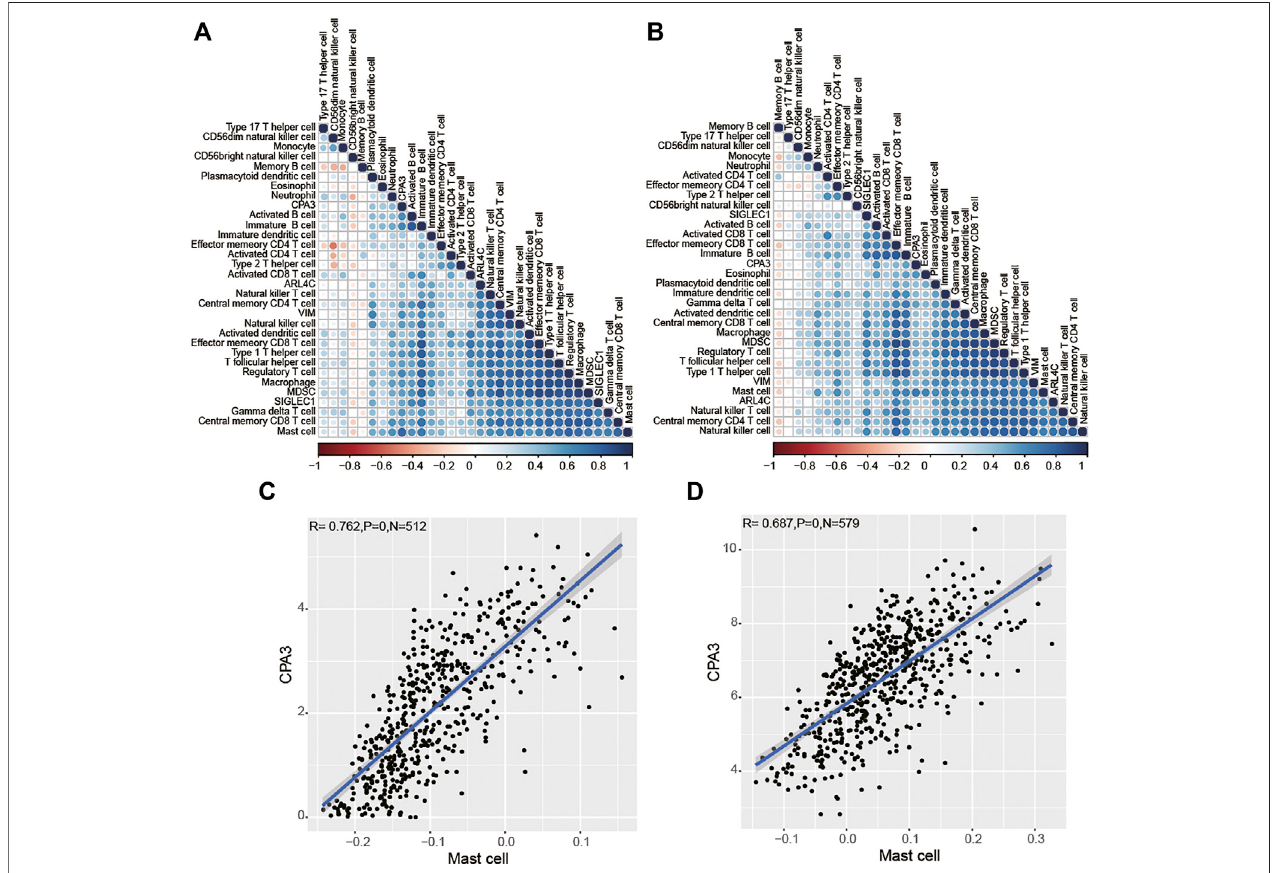
FIGURE 7 | Relationships between the four prognostic genes and immune cells based on TCGA (A) and GSE39582 (B) dataset analysis. CPA3 was highly correlated with Mast cells in TCGA (C) and GSE39582 (D) datasets.